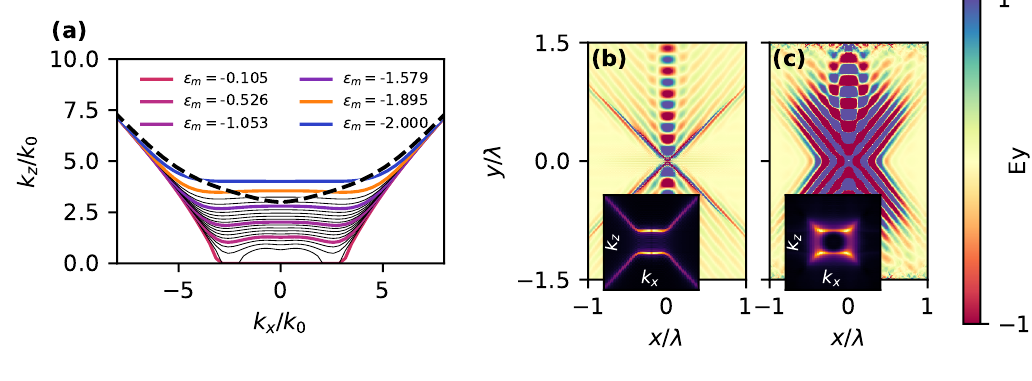
Figure 5. ( a ) Propagation constant for the symmetric three layer system (dashed black line, uniaxial metal-isotropic dielectric-uniaxial metal) and for asymmetric (uniaxial metal-isotropic dielectric-isotropic metal) system, plotted for various different ε m . Orange line indicates ε m = − 1.89 chosen for the simulations. ( b ) Semi-analytically calculated fields for low-loss ( γ = 0.01) system. ( c ) Simulated fields as per FEM simulations with γ =